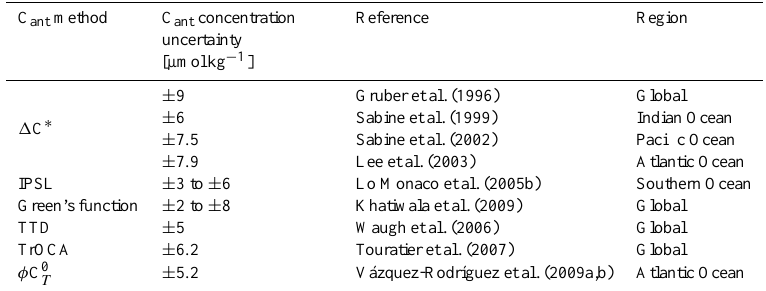
Table A1. Published estimates of uncertainties in C ant calculation for various estimation methods.